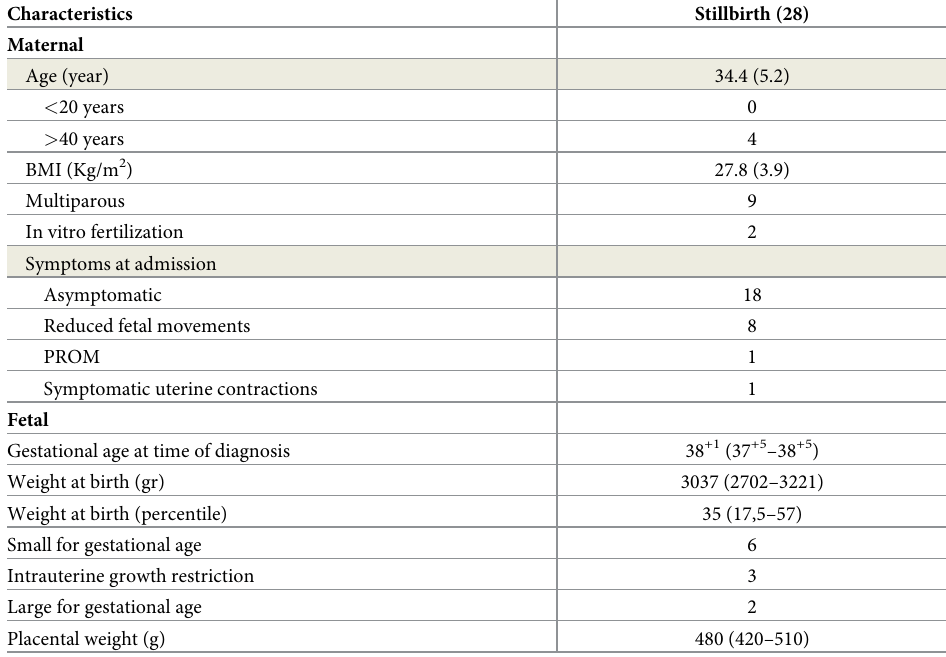
Table 1. Maternal and fetal characteristics of intrauterine death (number of cases, mean and standard deviation or median and interquartile range, where appropriate).